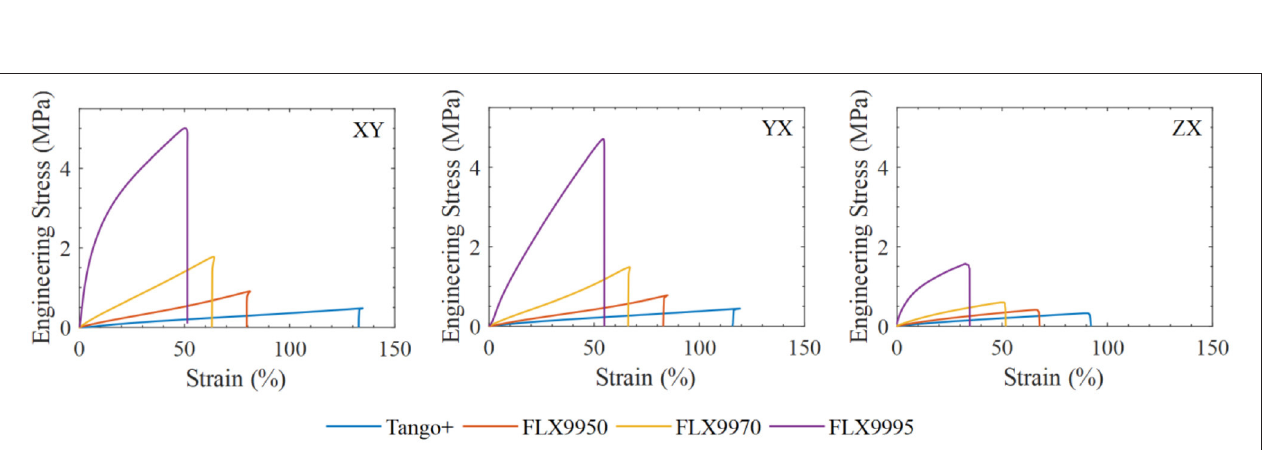
FIGURE 6 | Soft materials. Sample comparison of the stress-strain curves of the different materials and orientation considered.